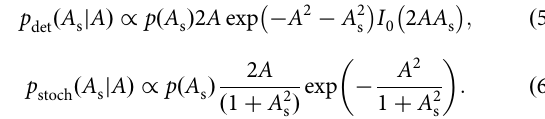
ffiffiffiffiffiffiffiffiffiffiffiffiffiffiffiffiffiffiffiffiffiffiffiffiffiffiffiffi p (cid:3) ln ð 1 (cid:3) 0 : 95 Þ